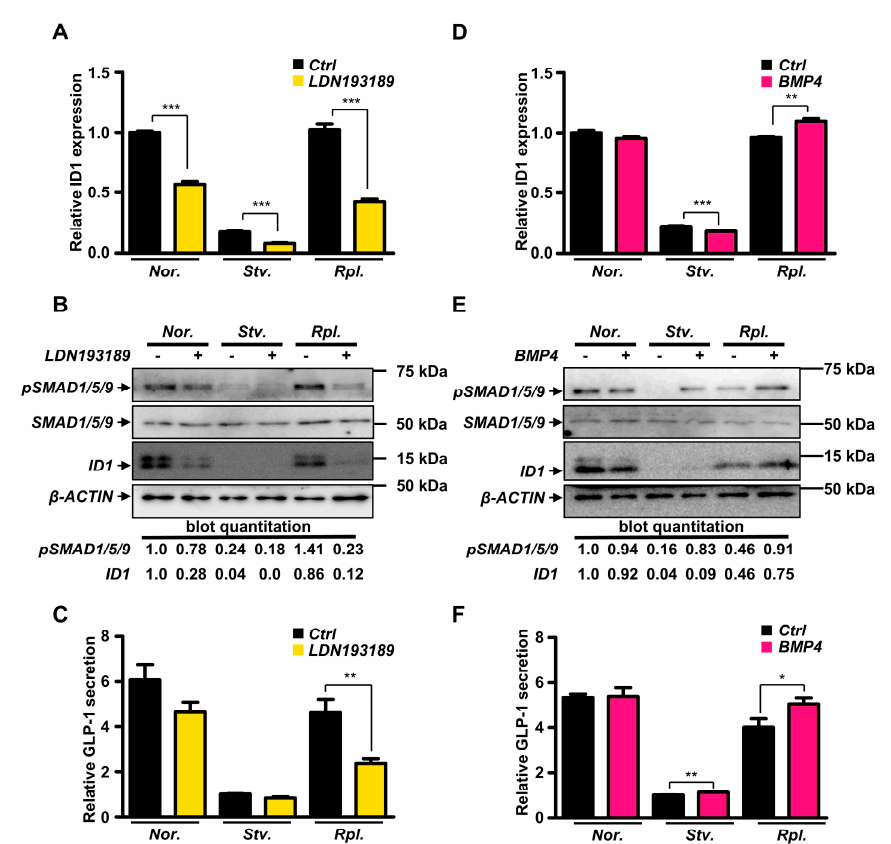
Figure 4. Modulation of BMP signaling pathway controlled GLP-1 secretion in GLUTag cells. ( A – C ) GLUTag cells were pre-treated with 10 nM LDN193189 for 24 h . ( A ) mRNA expression of ID1 gene with LDN193189 ( n = 4). ( B ) Protein level of ID1 gene with LDN193189. ( C ) GLP-1 secretion with LDN193189 ( n = 9). ( D − F ) GLUTag cells were pre-treated with 20 ng/mL of BMP4 for 2 h. ( D ) mRNA expression of ID1 gene with BMP4 ( n = 3). ( E ) Protein level of ID1 gene with BMP4. ( F ) GLP-1 secretion with BMP4 ( n = 6). Data represent the mean ± SEM. * p < 0.05; ** p < 0.01; *** p < 0.001; Student’s t -test.